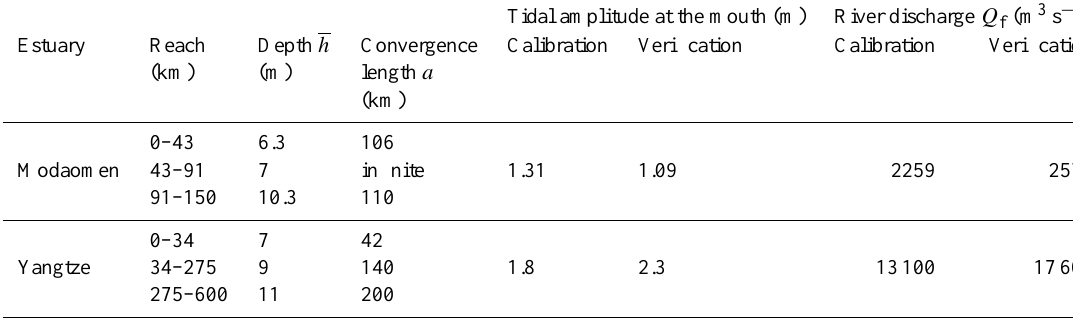
Table 4. Geometric and flow characteristics of the estuaries studied.